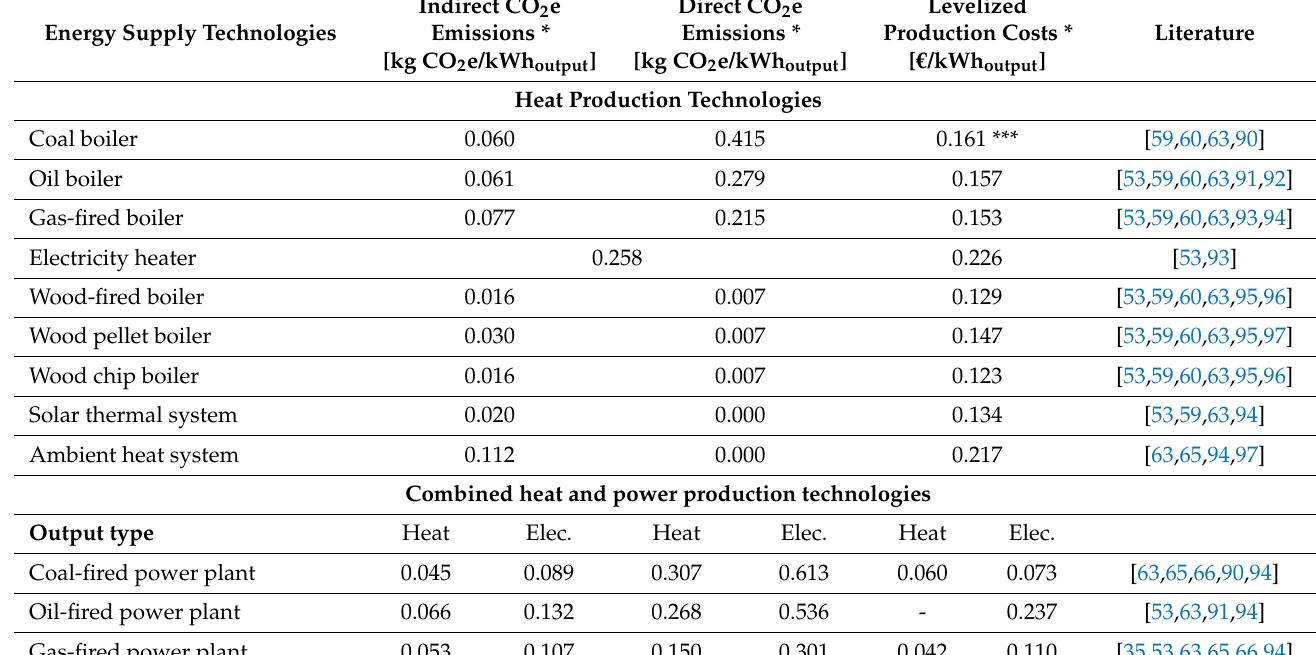
Table 2. Ecologic and economic factors of supply technologies within ENECO 2 Calc for the year